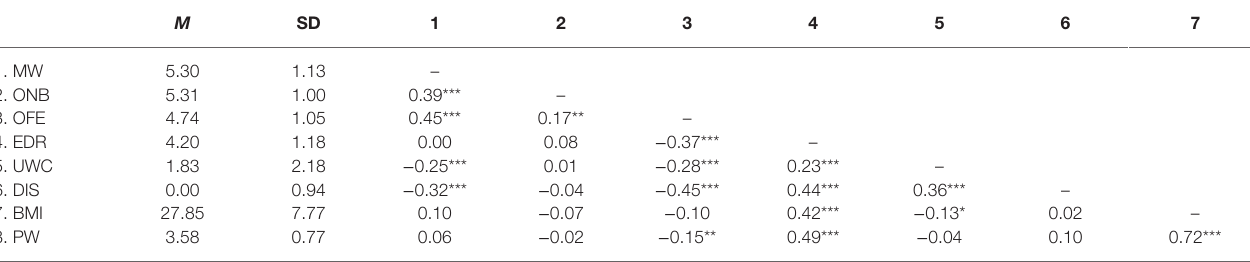
TABLE 1 | Scale means, standard deviations, and correlations Study